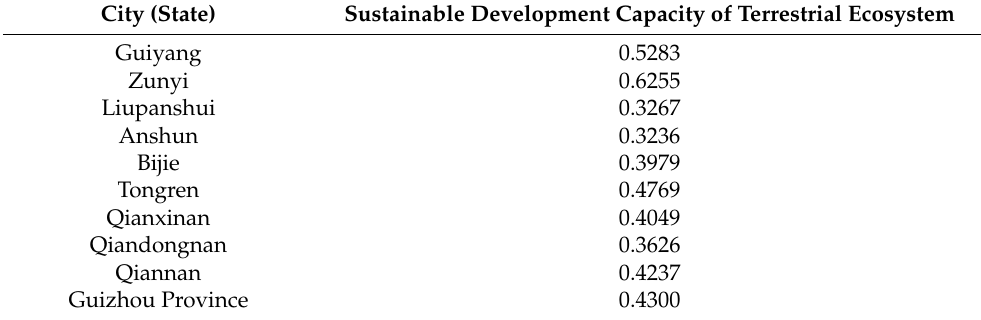
Table 7. Sustainable development capacity of the terrestrial ecosystem in each